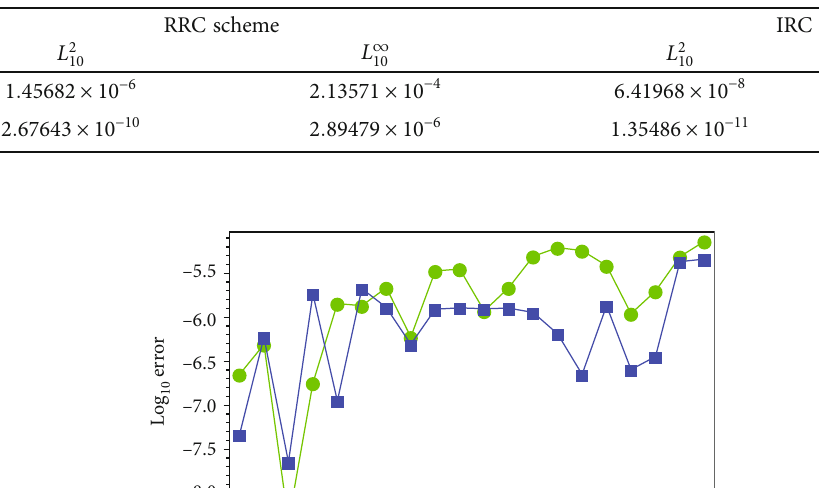
and L ∞ on interval x ∈ ½ 0, 10 (cid:2) for λ = 2 . 10 10